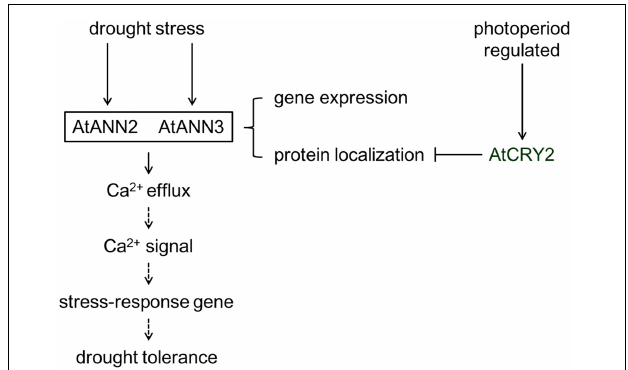
FIGURE 11 | Working model of the regulation of AtANN2 and AtANN3 in drought tolerance by photoperiod. The functions and subcellular localizations of AtANN2 and AtANN3 in drought tolerance were dependent on the photoperiod. Under normal conditions, AtANN2- and AtANN3-dependent GFP signals were widely expressed within the cells, not only at the plasma membrane. In response to drought stress, they could target to the plasma membrane for a short time (5 min) and acted as Ca 2 + channels to caused Ca 2 + efflux. Their gene expression was also changed after drought treatment by longer time (24 h) signals. Cytoplasmic free calcium ([Ca 2 + ] cyt ) might alter triggered calcium signaling. Calcium signaling caused downstream expression of genes associated with drought stress and thus adaptation to environmental changes. AtCRY2 is proposed to repress functions of AtANN2 and AtANN3 by affecting their plasma membrane localization to inhibited AtANN2 and AtANN3-dependent transmembrane Ca 2 + flow in response to drought stress.